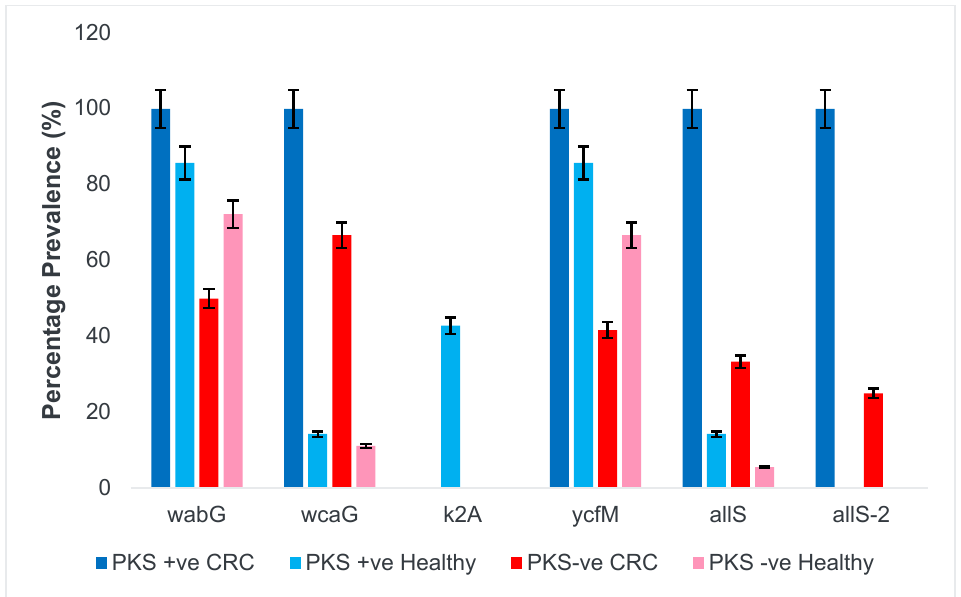
Figure 4. Prevalence of allantoin metabolism and lipopolysaccharide among K. pneumoniae isolates. Lipid polysaccharide (LPS) synthesis ( wabG ), fucose capsule synthesis ( wcaG ), capsule synthesis (K2 serotype capsule synthesis ( k2A ), outer membrane lipoprotein ( ycfM ), and allantoin metabolism ( allS, allS2